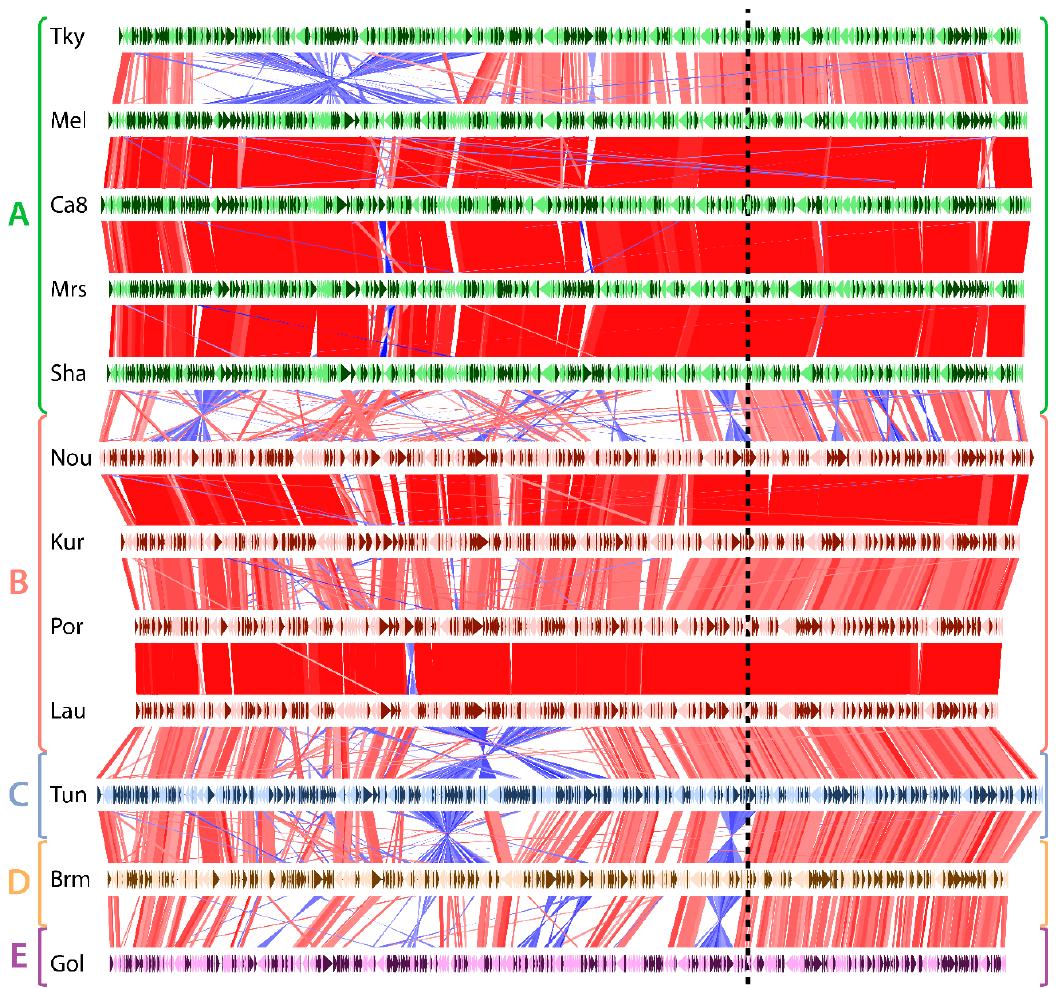
Figure 2. Genomic rearrangements in marseilleviruses. Each horizontal line represents a viral genome, namely: tokyovirus (Tky), melbournevirus (Mel), cannes 8 virus (Ca8), marseillevirus (Mrs), marseillevirus shanghai (Sha), noumeavirus (Nou), kurlavirus (Kur), port-miou virus (Por), lausannevirus (Lau), tunisvirus (Tun), brazilian marseillevirus (Brm) and golden marseillevirus (Gol), grouped and color-coded according to the clade it belongs to (shown on le left). Genes encoded on the forward strain are shown in dark colors and genes on the reverse strand in light colors. Vertical red and blue lines represent homologous genes between a pair of genomes. Red lines correspond to genes that are in the same direction, while blue lines represent inverted genes. The dashed vertical line separates the region prone to genomic rearrangements (on the left) from the one relatively depleted in rearrangements (on the right).